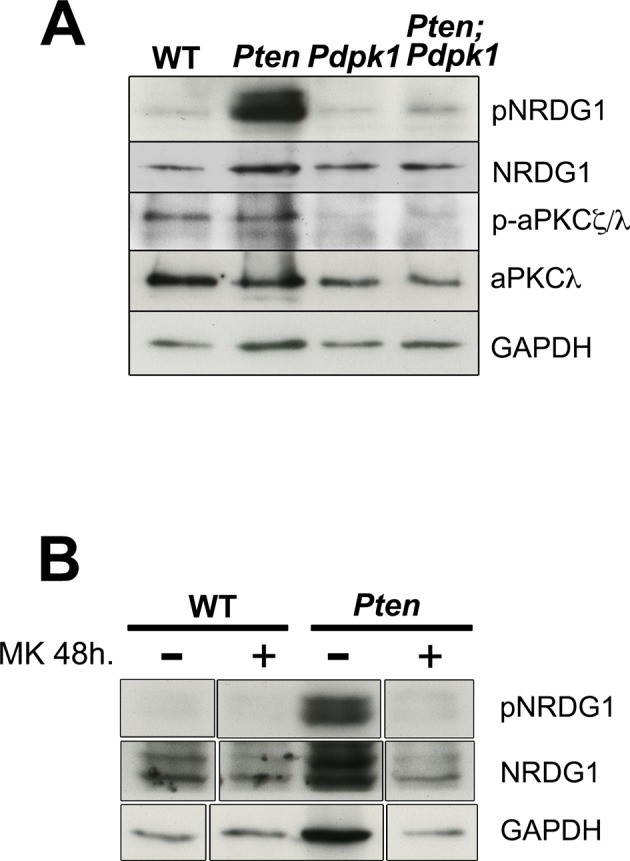
Downstream targets of PDPK1.(A) Western blots for pNRDG1 and p-aPKCζ/λ in E8.5 WT Pten △Epi, Pdpk1 △Epi and Pten △Epi Pdpk1 △Epi embryos. (B) Western blot analysis of pNRDG1 in WT and Pten △Epi embryos treated with MK2206 for 48 hr.